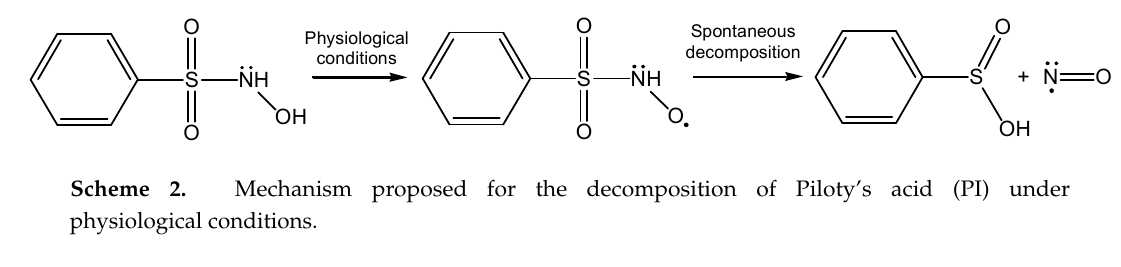
Spontaneous decompositionPhysiological